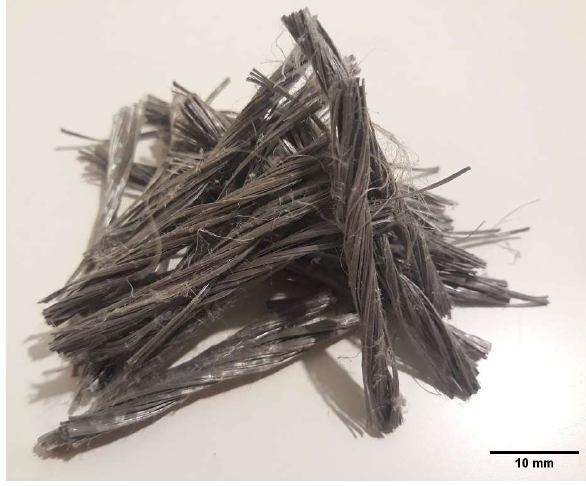
Figure 1. Twisted fibers used in the manufacturing of fiber-reinforced concrete. Table 2. Specifications of tested